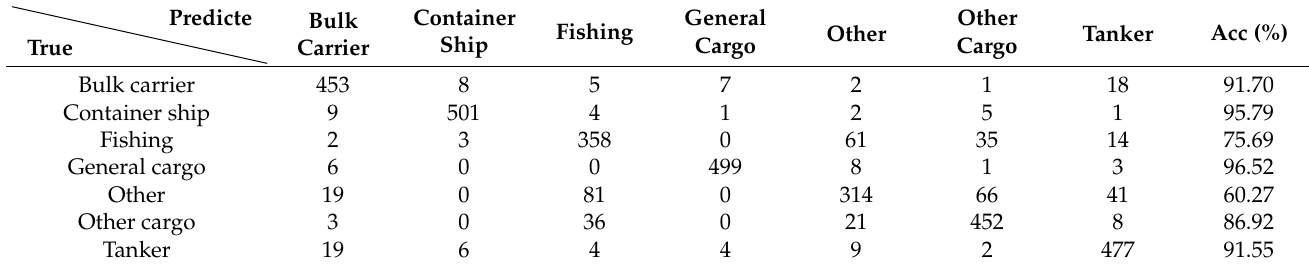
Table 10. Classification confusion matrix of ResNet + HOG on the FUSAR-Ship dataset.